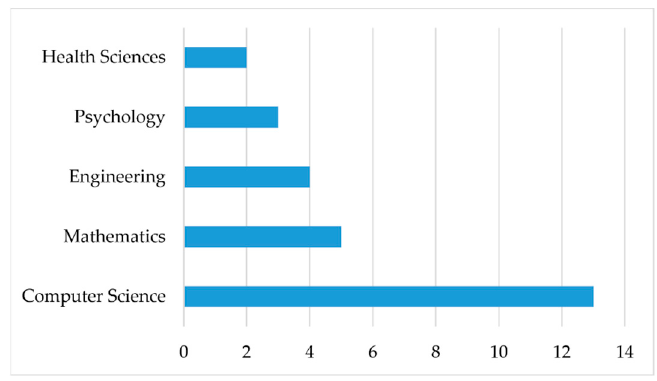
Figure 8. Frequency of prediction studies per type of major.